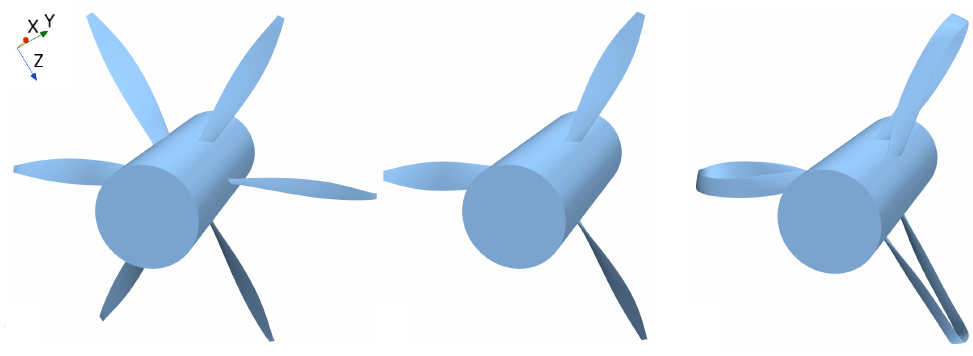
Figure 3. From left to right: Conprop-6, Conprop-3 and Boxprop. Table 1. The primary parameters targeted to achieve in the design of the